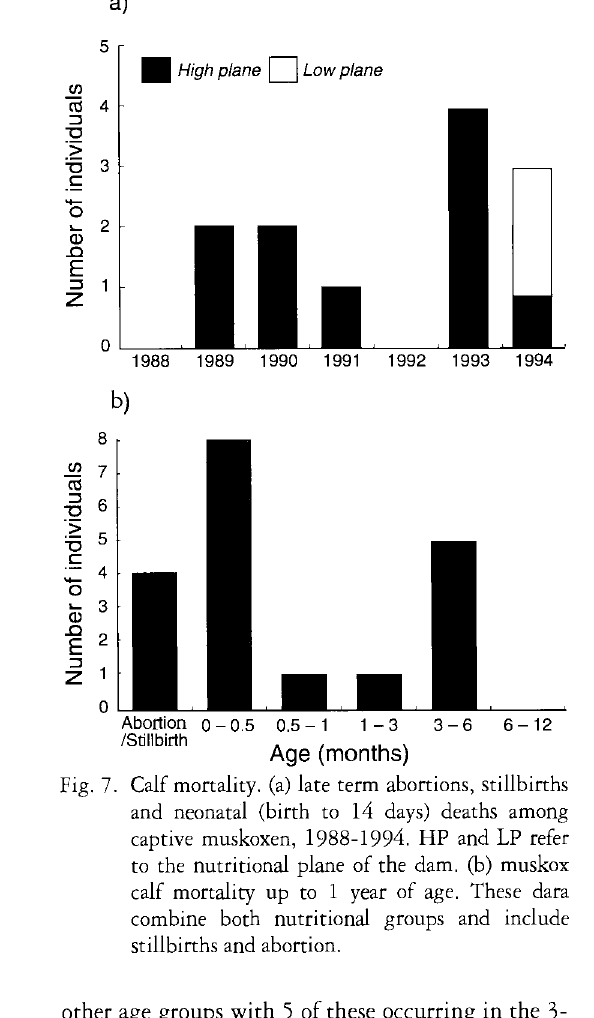
Fig. 7. Calf mortality, (a) late term abortions, stillbirths and neonatal (birth to 14 days) deaths among captive muskoxen, 1988-1994. HP and LP refer to the nutritional plane of the dam. (b) muskox calf mortality up to 1 year of age. These dara combine both nutritional groups and include stillbirths and abortion.